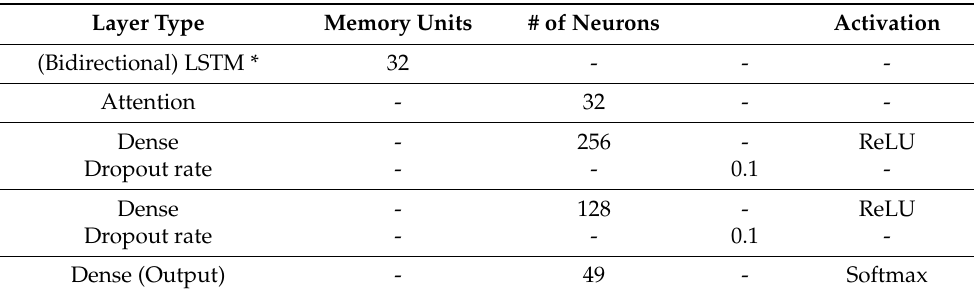
Table 3. LSTM and BiLSTM with Attention models. Layer